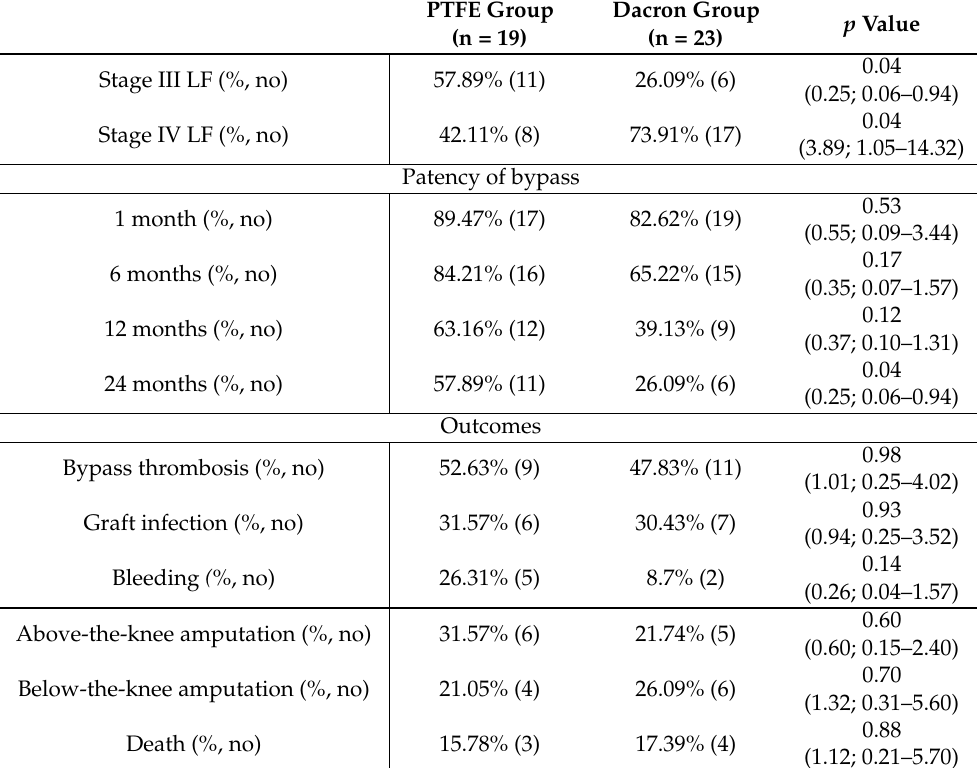
Table 5. Leriche–Fontaine classification, patency, complications, and outcomes of BK FP bypass